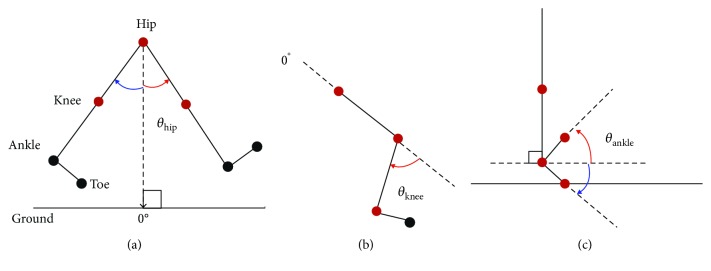
Definition of joint angles S(ang): (a) flexion/extension of hip joint θhip, (b) flexion/extension of the knee joint θknee, and (c) dorsi-/plantar-flexion of ankle joint θankle. The red points indicate joints, and the red/blue arrows denote the positive/negative sign of angular direction.